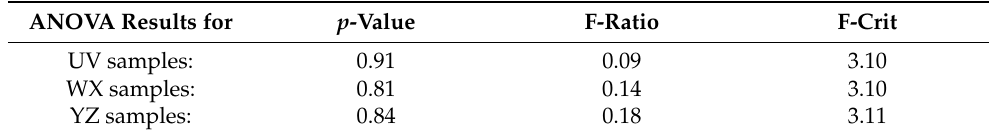
Table 9. Three MOV manufacturer ANOVA